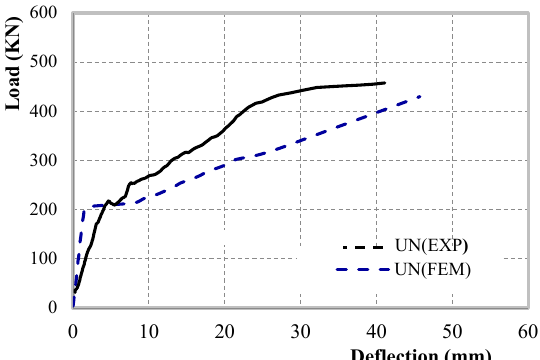
Figure 20. Load-deflection curve of UN slab.